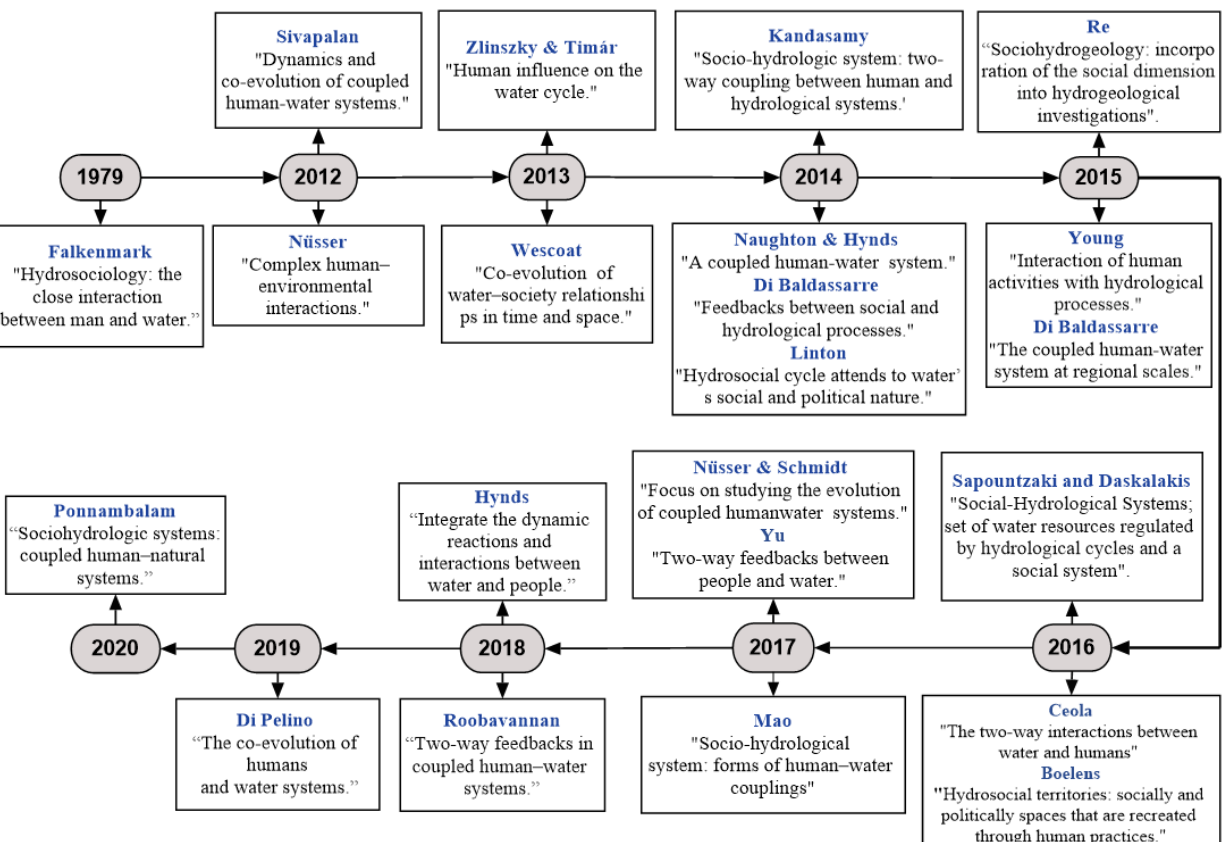
Figure 2. Chronological diagram of the definitions of socio-hydrology.